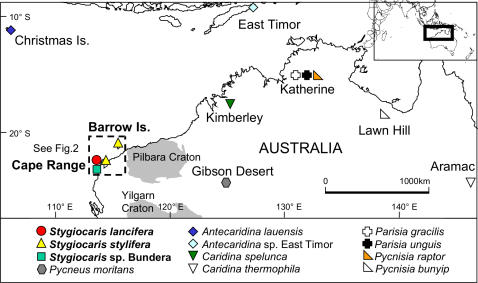
Map of collection locations of subterranean atyids in the Australian region.See Tables 1, 2 for site details.